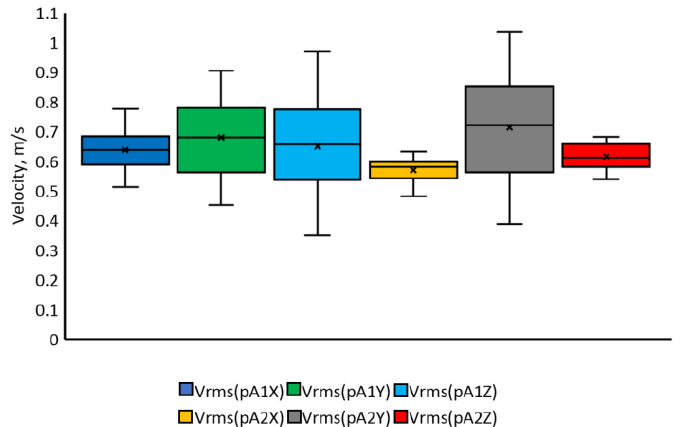
Figure 9. Summary of the maximal velocity values obtained in the study of reaching movements in the acceleration phase.